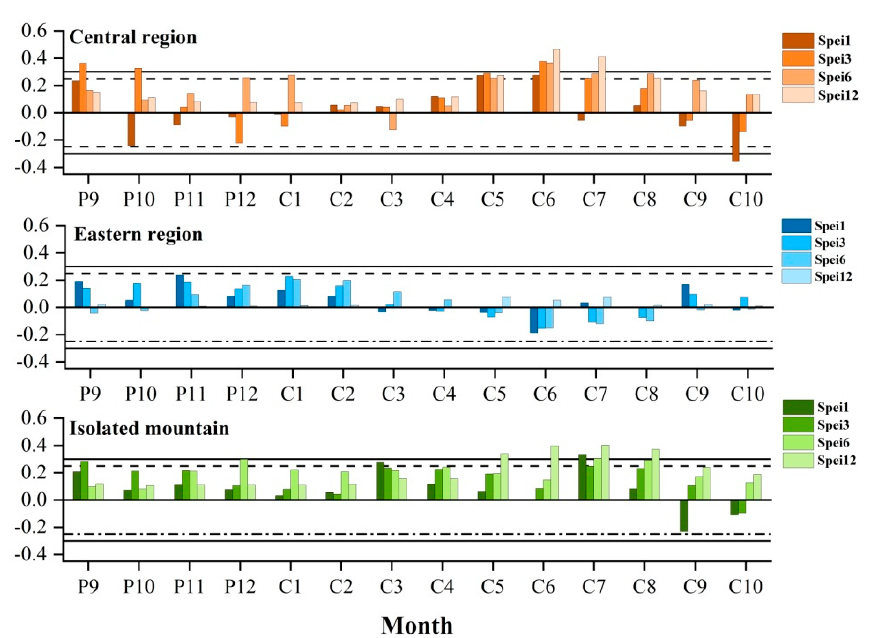
Figure 6. Correlations between tree-ring width chronologies and standardized precipitation evapo- transpiration index (SPEI) in the three Central and Eastern Qilian Mountain regions.